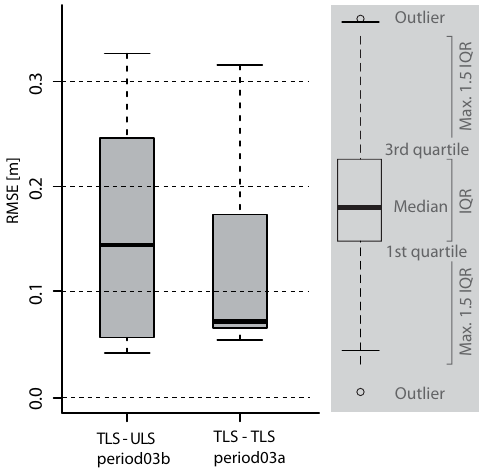
Figure 6. Boxplots comparing root-mean-squared errors (RMSE) of 3D displacement vectors obtained from ICP-Matching with either TLS to ULS or TLS to TLS data. IQR: Interquartile